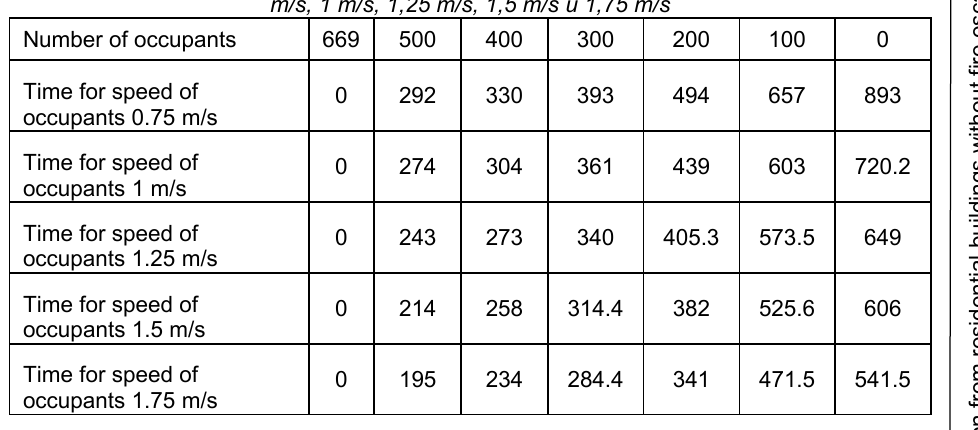
Table 11 – Simulation results in seconds for the third scenario, with elevators enabled and the first and the second entrances/exits blocked and for the occupants’ speeds